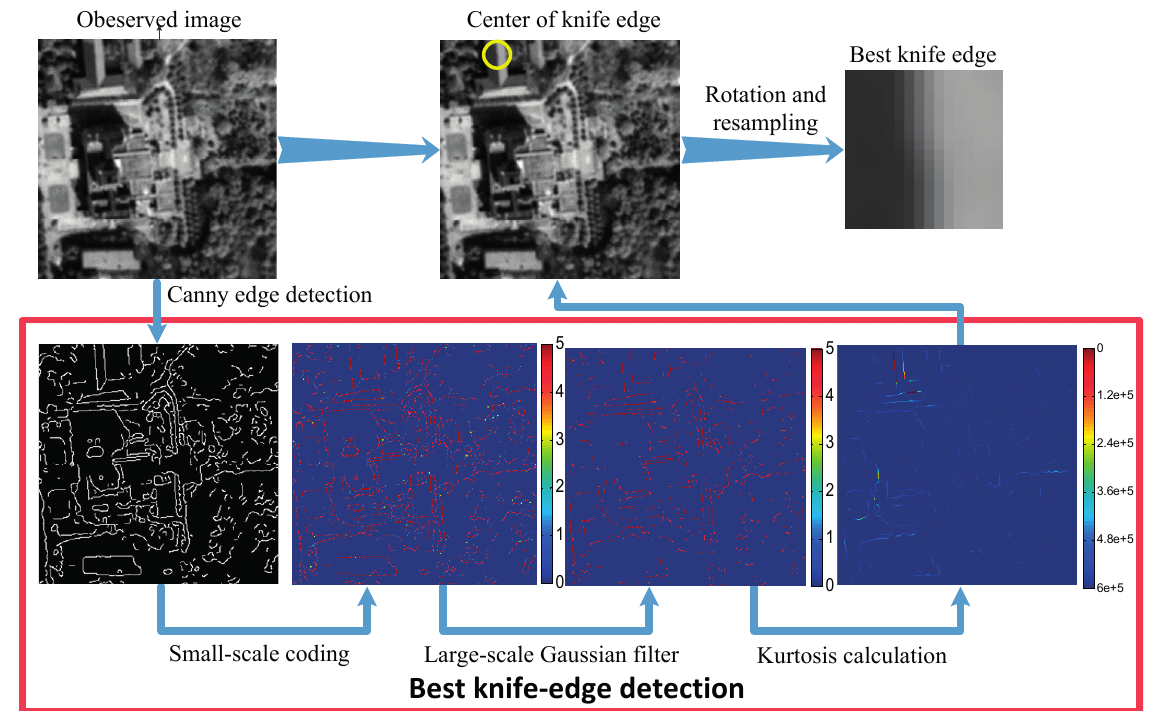
Figure 1. Example of the best knife-edge detection